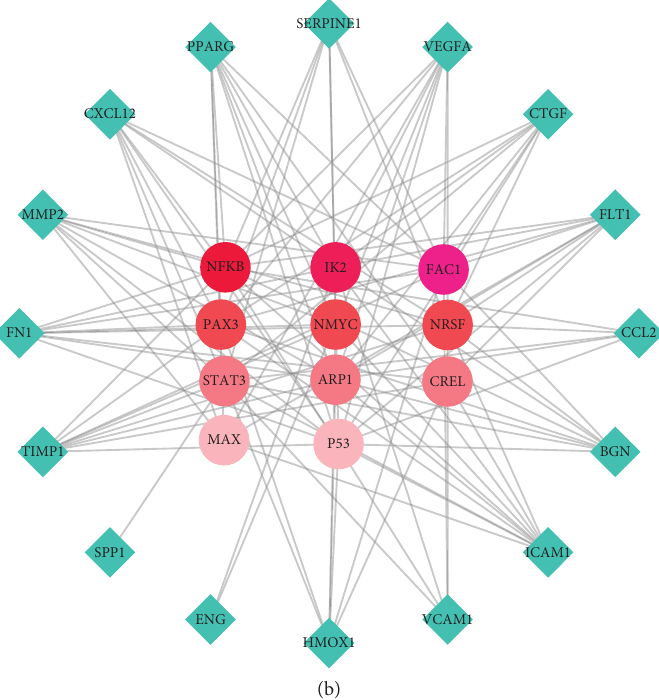
Figure 5: (a) Interaction network between miRNAs and their target genes. Genes were indicated by purple arrows and miRNAs were represented by blue circles. Moreover, miRNAs targeting two genes were shown by green circles. (b) Interaction network between genes and TFs. The diamonds represented genes and circles indicated TFs. The smaller the p value, the darker the circle color. miRNAs: microRNAs; TFs: transcription factors.